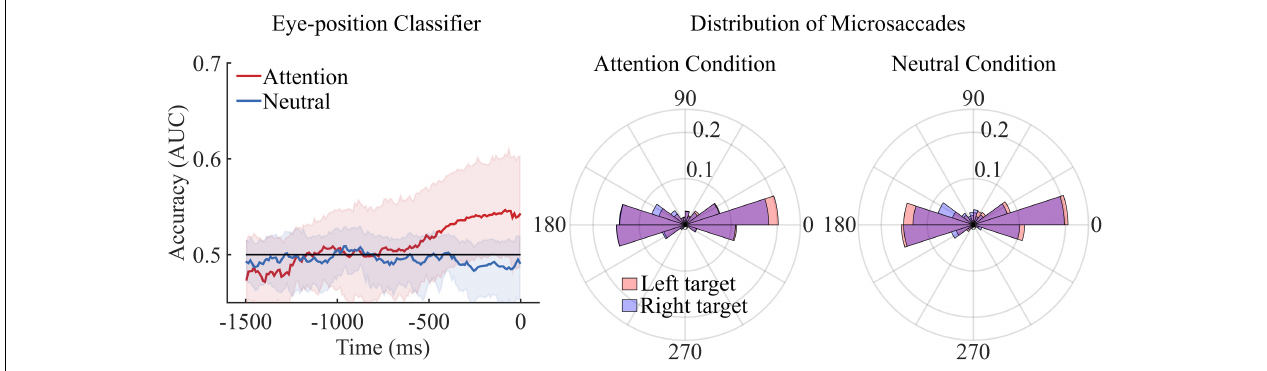
FIGURE 3 | The left graph depicts decoding accuracy for the eye-gaze data. As for the raw EEG activity we averaged the time points corresponding to 10 ms in successive time windows. Neither the attention classifier nor the neutral classifier could decode significantly above chance level left versus right target trials. The same results were observed when time points were averaged in 50 and 100 ms successive time windows. Shaded areas represent bootstrapped confidence intervals. The central and right polar histograms depict the distribution of directions of microsaccades executed during left and right target trials for both the attention and the neutral condition. No difference was observed in the distribution of microsaccades between left and right target trials of the attention and neutral condition.